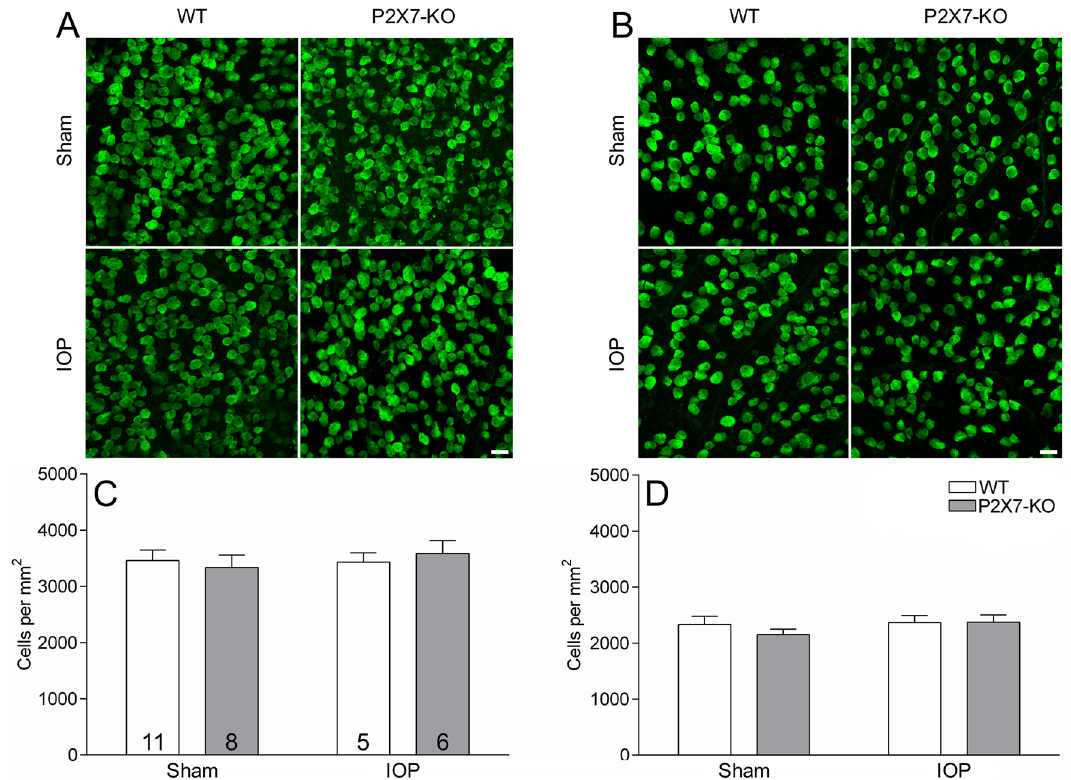
Figure 7. RGC numbers are not altered in either WT or P2X7-KO retinae following acute IOP elevation. RGCs were immunohistochemically labelled with RBPMS and images of representative staining of the central ( A ) and peripheral ( B ) eccentricities are shown. RGC counting showed no difference in RGC number between central ( C ) and peripheral ( D ) eccentricities. Numbers in histogram indicate number of animals. Scale bar 20